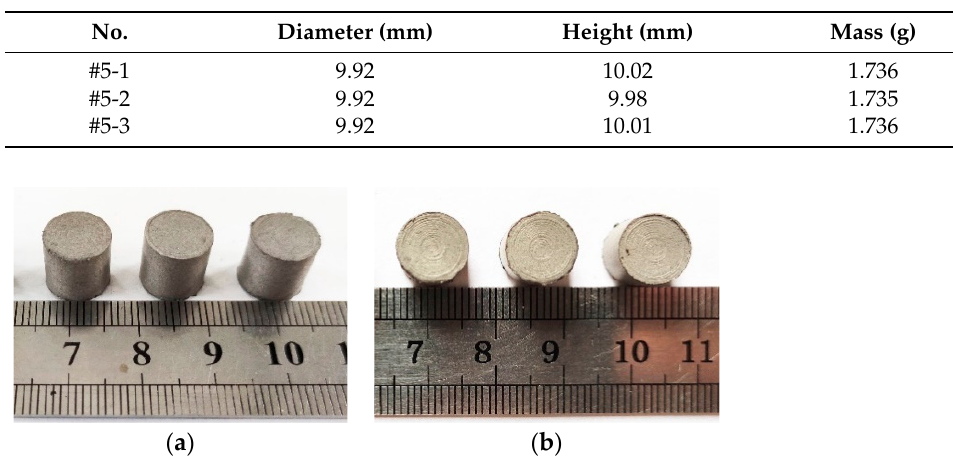
Table 1. Structural parameters of PTFE/Al/Si reactive material samples.